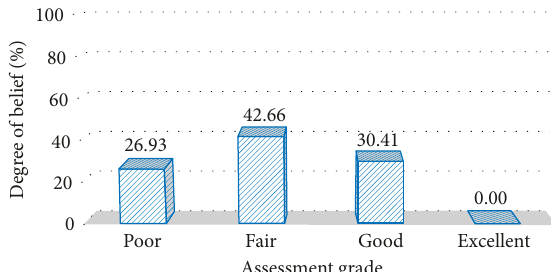
Figure 5: Overall bridge condition assessment based on the an- alytical ER